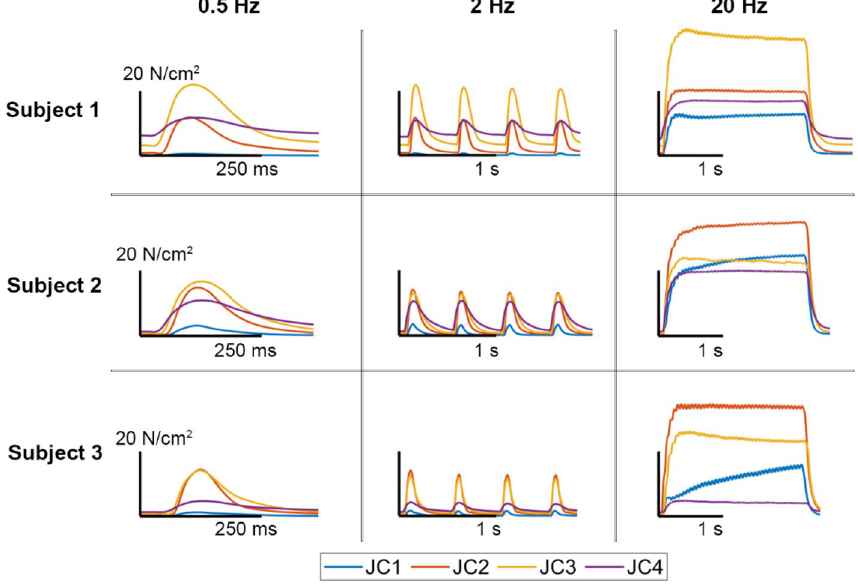
Figure 13. Intraoperative contractile record for three subjects. The columns show the CMAP, 2 Hz and 20 Hz muscle response for each joint configuration (JC). Data were filtered using a fourth-order low pass Butterworth filter and a cutoff frequency of 30 Hz. Total force was normalized to muscle physiological cross-sectional area. Time scale bars are labeled for each plot. Hip abduction (HA) and knee flexion (KF) angles for each JC are written as (HA, KF). JC1 (45°, 130°), JC2 (45°, 90°), JC3 (45°, 45°) and JC4 (60°, 0°). Hip flexion was constant at 60° throughout. The baseline force for each contractile record shows the amount of passive tension present in the gracilis MTU. There is an increase passive tension from JC1 to JC4.